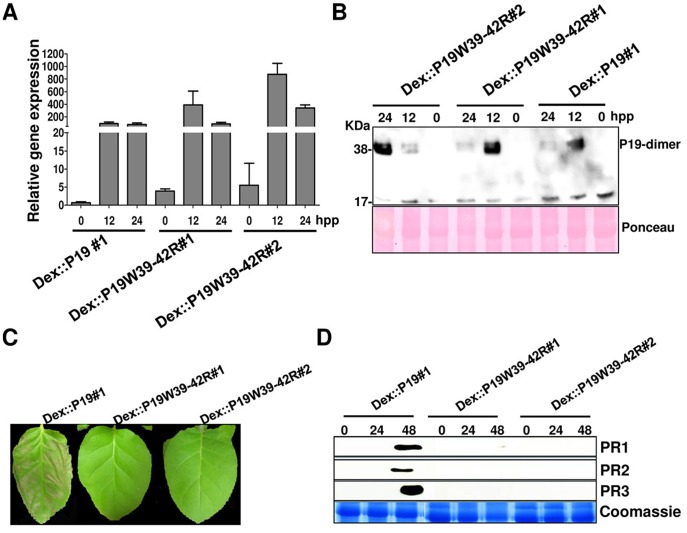
Binding of small RNAs is mandatory for induction of plant immune responses by P19.(A–B) Leaves of five week old Dex::P19, Dex::P19W39-42R transgenic lines (N. tabacum cv. Xanthi) were sprayed with DEX and the kinetics of P19W39-42R accumulation at transcript (A) and protein (B) levels was analysed by qPCR and Western analysis, respectively. Actin was used as an internal control. (C) The transgenic lines described above were sprayed with DEX and appearance of an HR was assessed 5 day post-DEX application. (D) PR proteins accumulation at 0, 1 and 2 days post DEX application in Dex::P19 and Dex::P19W39-42R transgenic lines. Western analysis was conducted using anti-PR1, -PR2 and -PR3 antibodies. Coomassie or ponceau staining of the same extracts is shown to demonstrate equal protein loading. Experiments were repeated three times and showed similar results.